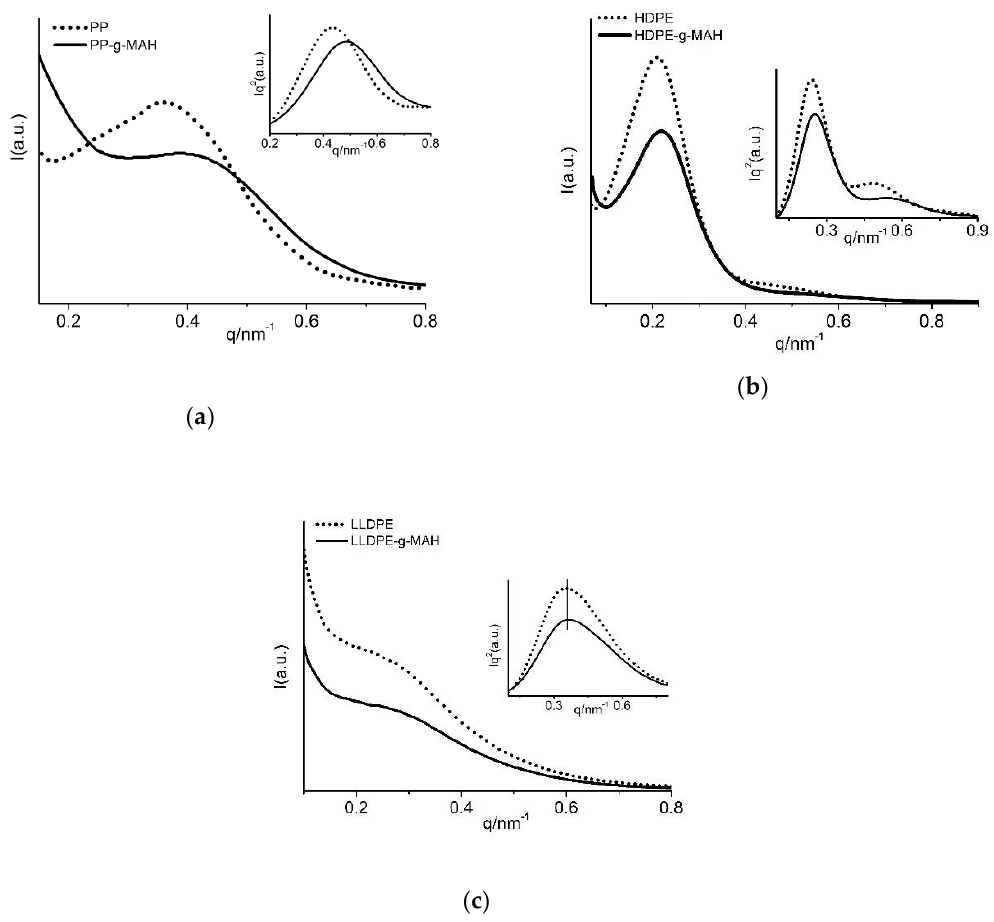
Figure 3. Linear and Lorentz-corrected SAXS profiles of different polymers. ( a ) PP and PP- g -MAH, ( b ) HDPE and HDPE- g -MAH, ( c ) LLDPE and LLDPE- g -MAH.